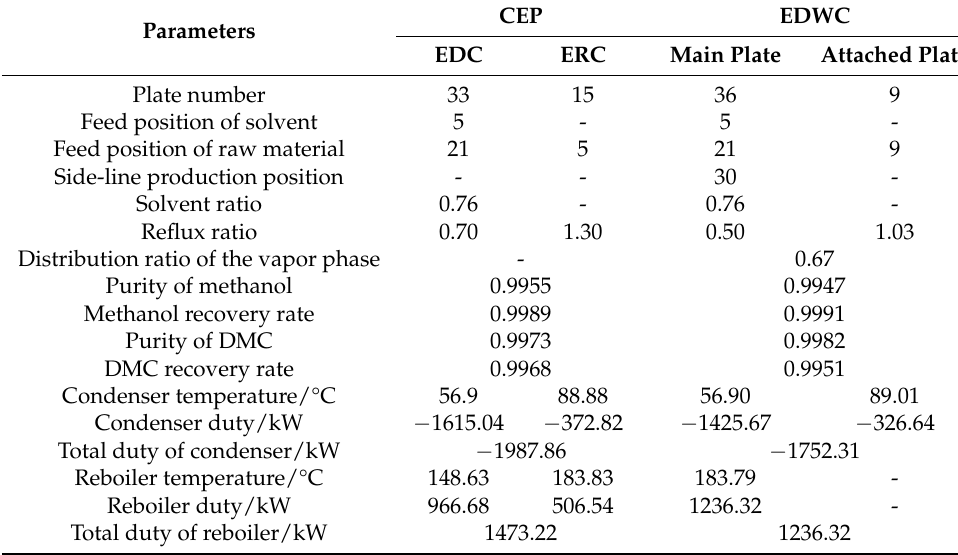
Table 2. Detailed operating parameters for CEP and